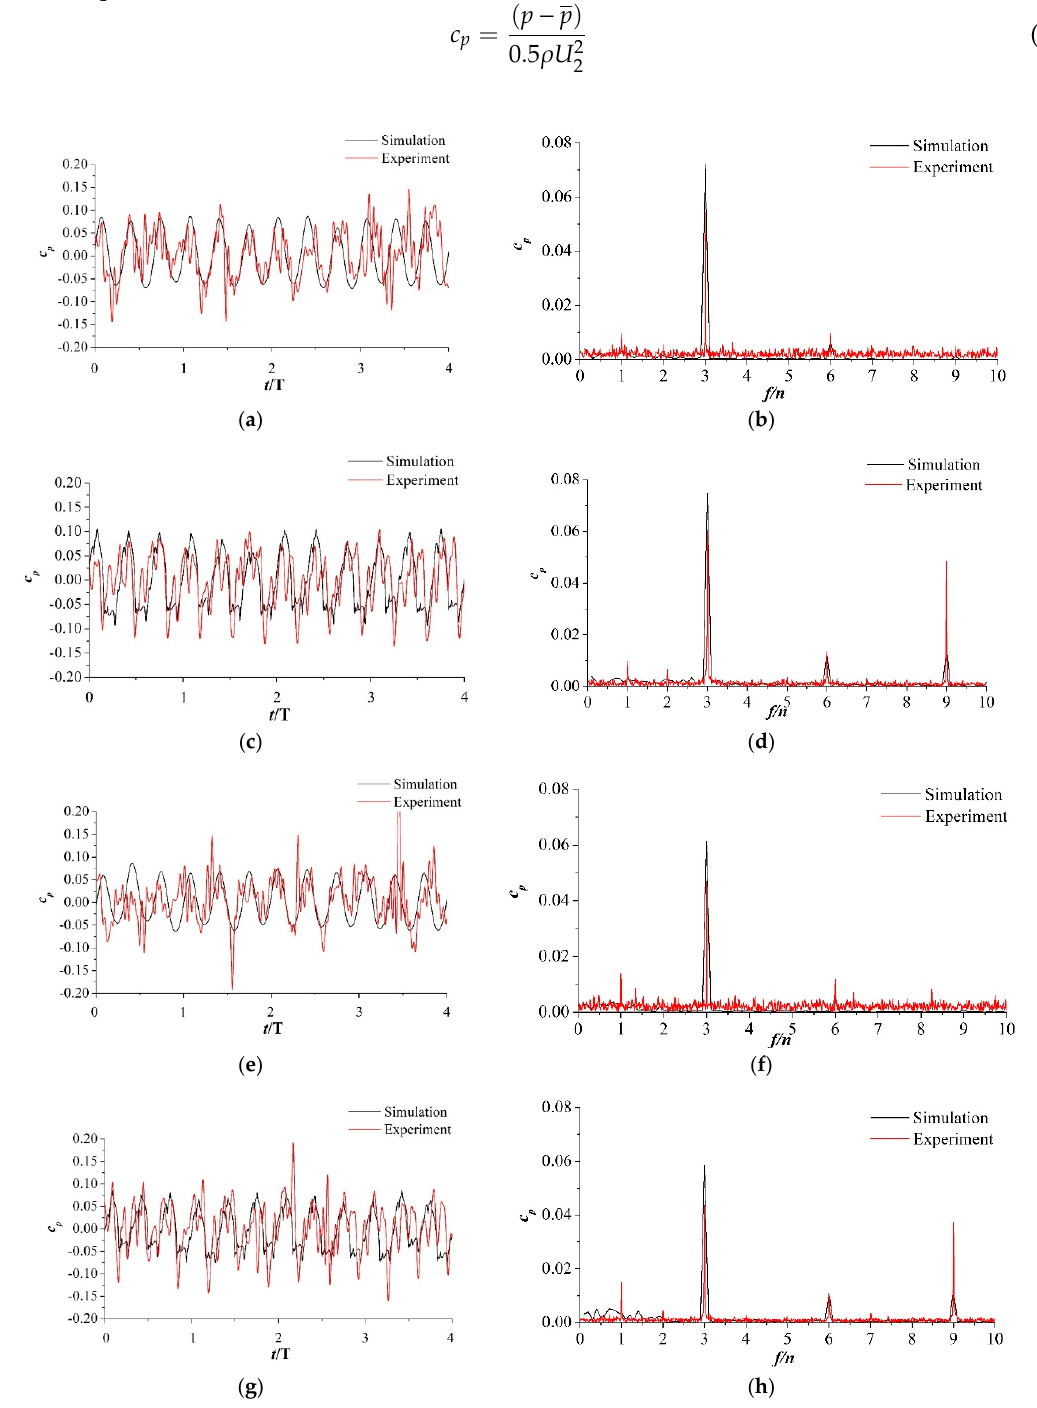
Figure 7. Time history and frequency domain of the monitor points pbt5 and FCA1 from the numerical and experimental results ( a ) Time history (pbt5, 1.0 × Q 0 ); ( b ) frequency domain (pbt5, 1.0 × Q 0 ); ( c ) time history (FCA1, 1.0 × Q 0 ); ( d ) frequency domain (FCA1, 1.0 × Q 0 ); ( e ) time history (pbt5, 0.8 × Q 0 ); ( f ) frequency domain (pbt5, 0.8 × Q 0 ); ( g ) time history (FCA1, 0.8 × Q 0 ); and ( h ) frequency domain (FCA1, 0.8 × Q 0 ).